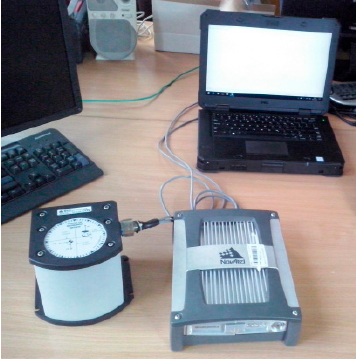
Figure 6 . LN200 inertial measurement unit during static testing. Figure 6. LN200 inertial measurement unit during static testing.